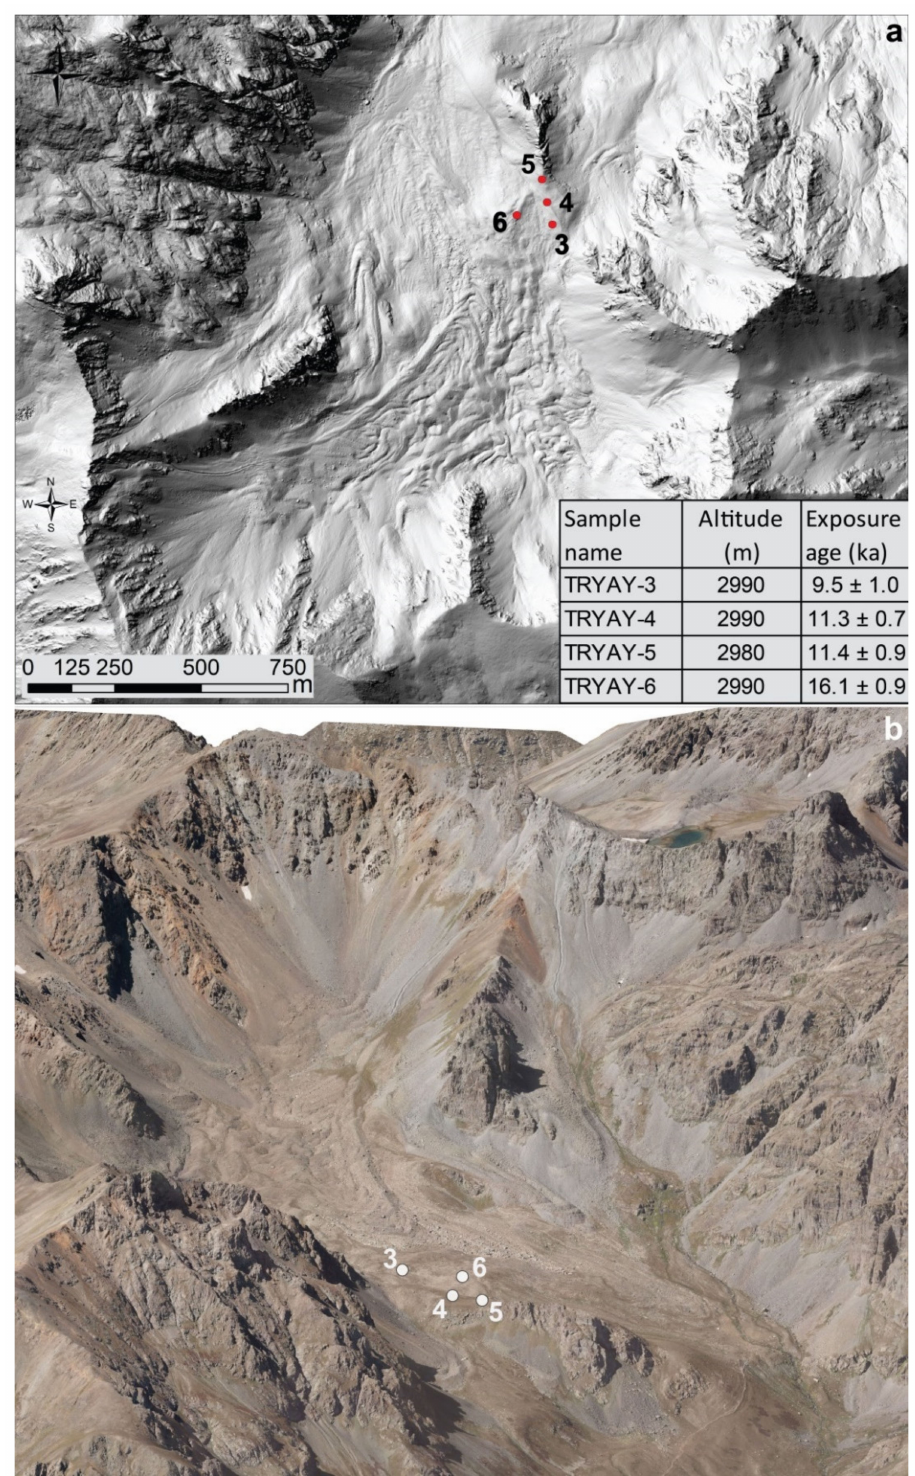
Figure 5. Reconstructions based on digital elevation data of uppermost Hastaf Valley with a spec- tacular view into the cirque to the SE of Mt. Kaçkar. ( a ) Detailed map with sample locations. ( b ) View of detailed reconstructions of land surface expressions. Samples are from areas with little periglacial